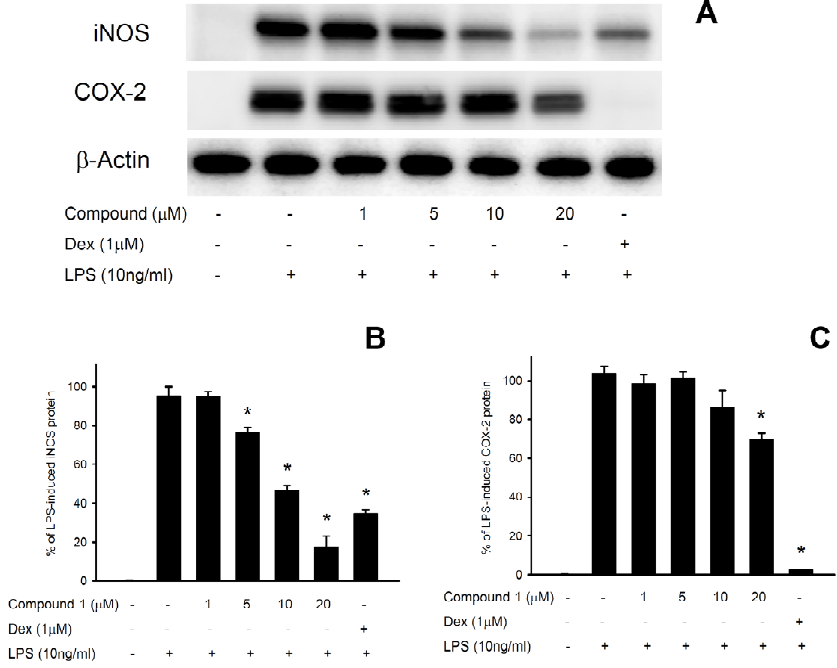
Figure 3. Effect of compound 1 on pro-inflammatory iNOS and COX-2 protein expression in LPS-stimulated murine macrophage cell line RAW264.7. ( A ) Western blots for iNOS, COX-2 and β -actin proteins from macrophage cells; ( B ) relative density of iNOS immunoblot; ( C ) relative density of COX-2 immunoblot. The relative intensity of the LPS-stimulated group was taken to be 100%. Band intensities were quantified by densitometry and are indicated as the percent change relative to that of the LPS-stimulated group. Compound 1 and dexamethasone (Dex) significantly inhibited LPS-induced iNOS and COX-2 protein expression in macrophage. The experiment was repeated three times. ( * p < 0.05, significantly different from the LPS-stimulated